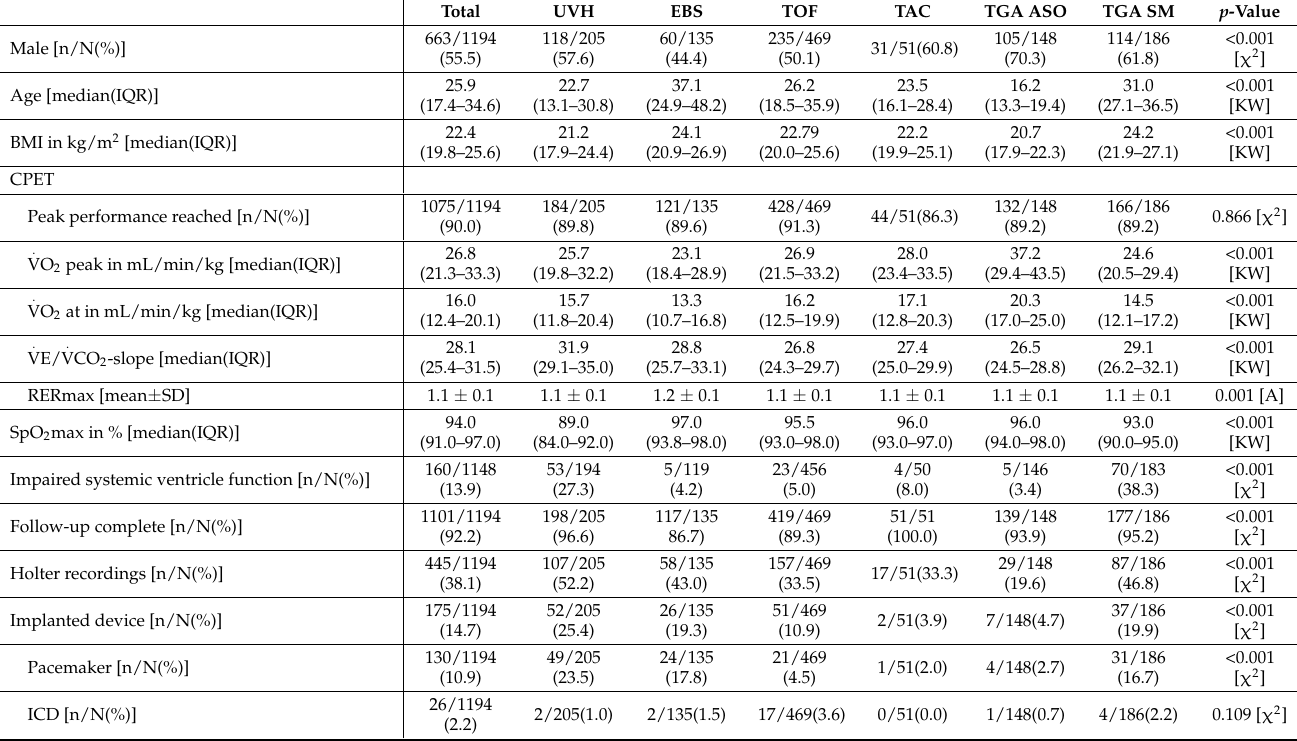
Table 1. Patient characteristics, results of CPET, and the applied means of rhythm recording (total and separated in CHD